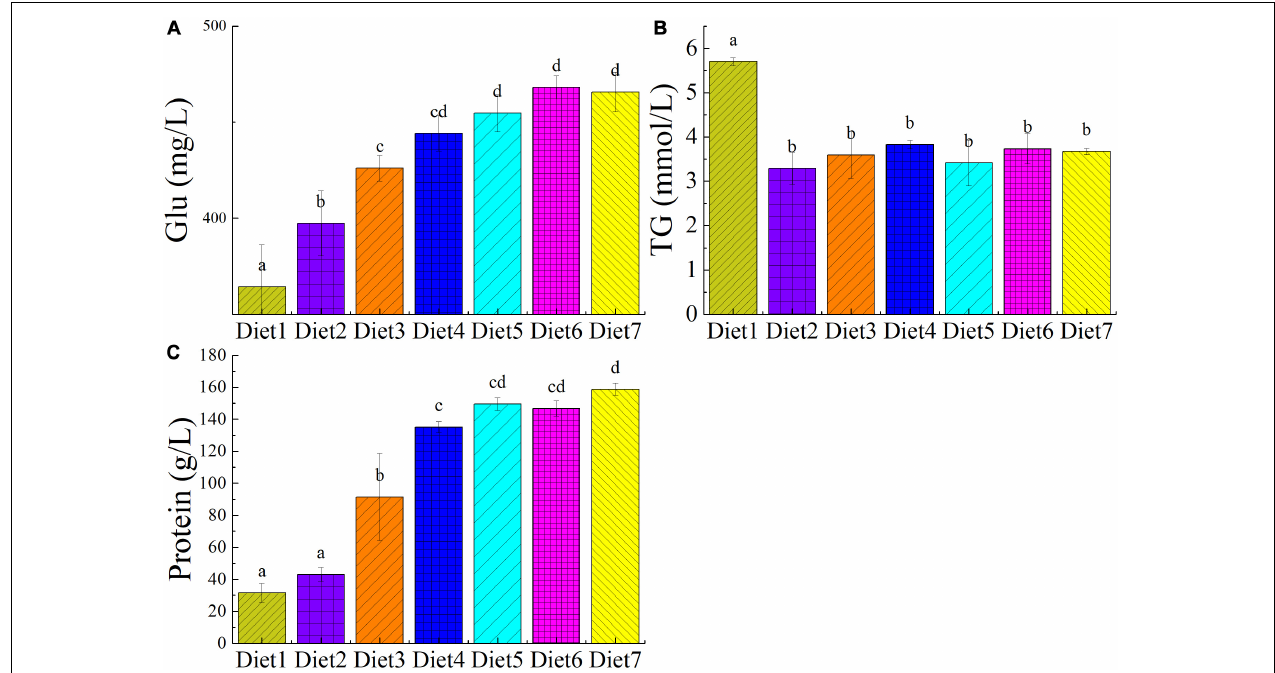
FIGURE 1 | The plasma biochemical indicators of T. ovatus sp. The plasma biochemical index of T. ovatus sp. fed with diets in different levels of n -3 PUFAs Diet1 ∼ 7 for Fish feed with different PUFA contents in 7 groups. Glucose (A) , triglyceride (B) , and protein (C) content in blood. The amount of Aurantiochytrium sp. powder in feed is 0.00%, 1.00%, 3.00%, 5.00%, 7.00%, 9.00%, and 11.00% respectively.